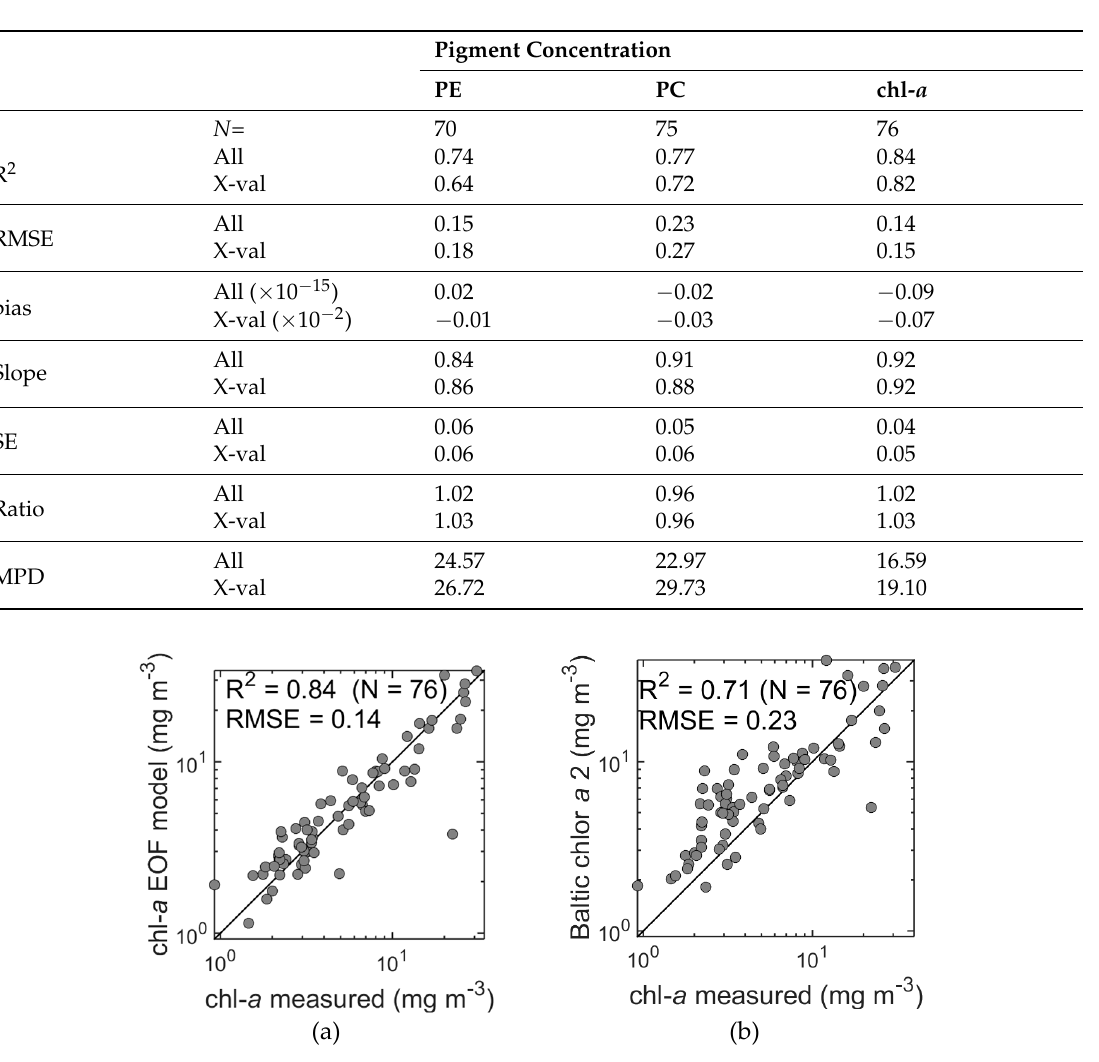
Table 5. Statistics of the EOF models for pigment concentration. Units are log 10 (mg · m − 3 ) for pigment concentration. Ratio and MPD are dimensionless.